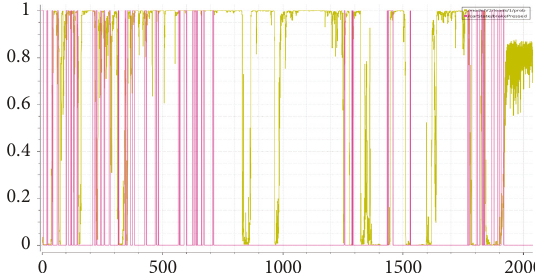
Figure 3: T1D1 lead car detection and braking.